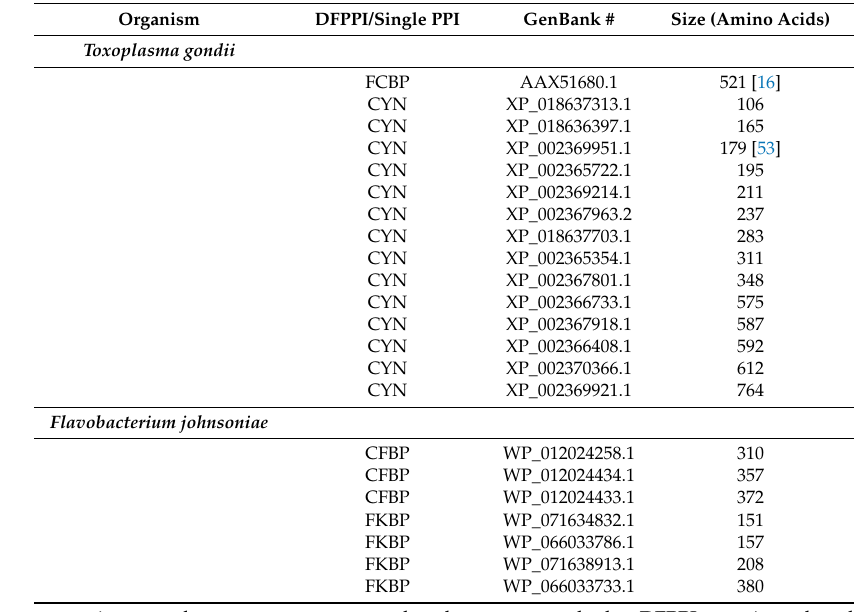
Table 2. Examples of co-existence of DFPPI and PPI paralogs a